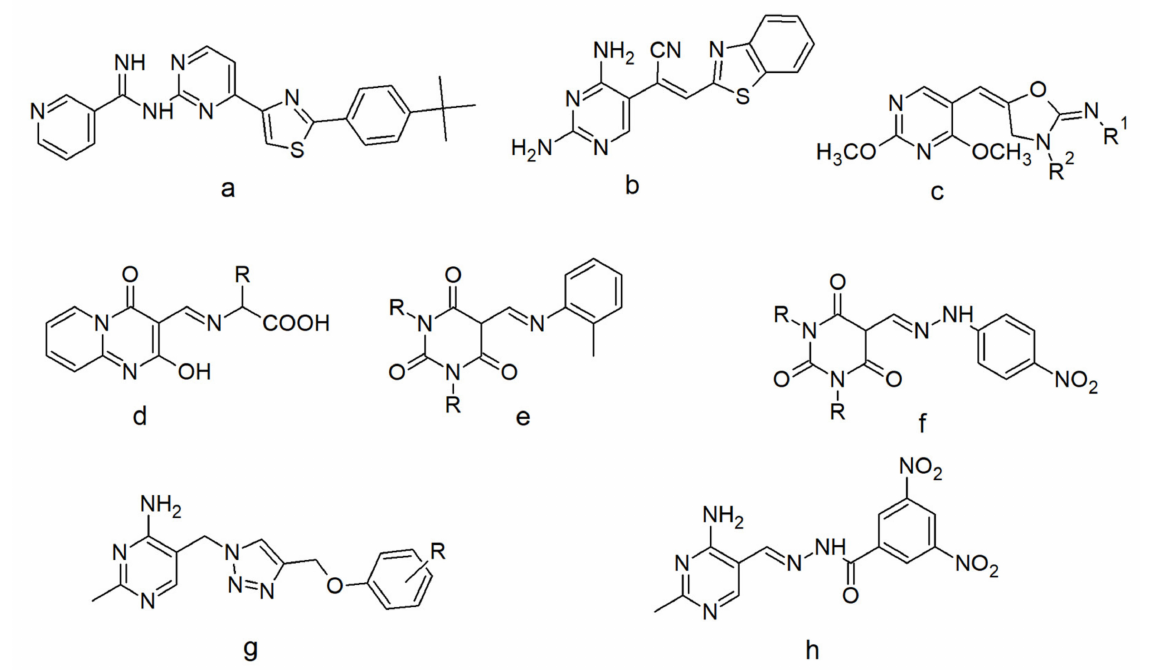
Figure 1. New potent antibacterial pyrimidines: derivative of 2,4-disubstitued pyrimidine ( a ); pyrimidines with the double bond of the chain at position 5 of the ring ( b , c ); pyrimidines containing the azomethine group at position 5 of the ring ( d – f ); lead structure ( g ) and the most active derivative obtained by He et al. ( h )The azomethine group is present in such classes of compounds as imines, oximes, or hydrazones that are formed in the reaction of carbonyl compounds with amines, hydroxylamine, or hydrazine, respectively. In the chemistry of pyrimidines, the formation of this group mostly employs the reaction of aminopyrimidines with aldehydes [26]. Sometimes pyrimidine-5-carbaldehyde is also used [27]. Imines substituted at nitrogen with alkyl or aryl group are known as Schiff bases and were first described in 1864 [28]. To date, many methods for their synthesis have been described. The most common employ the removal of water, using a catalytic amount of Lewis acids and irradiation techniques [29–32]. They still arouse the interest of scientists because of the wide range of pharmacological activities they exhibit, including, among others: antimicrobial [33], anticancer [34,35], anti-inflammatory [36], and analgesic activity